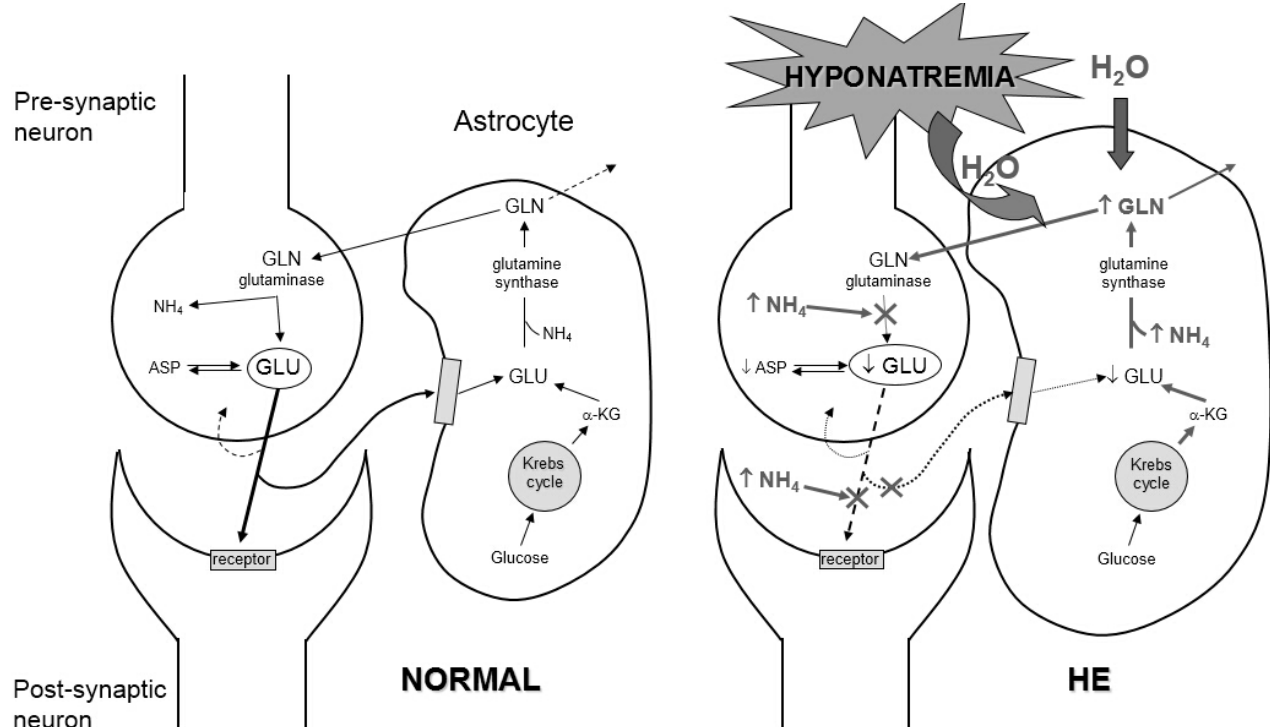
Figure 3. Schematic representation of glutamatergic pathway in normal subjects (NORMAL) and patients with hepatic encephalopathy (HE). Normal